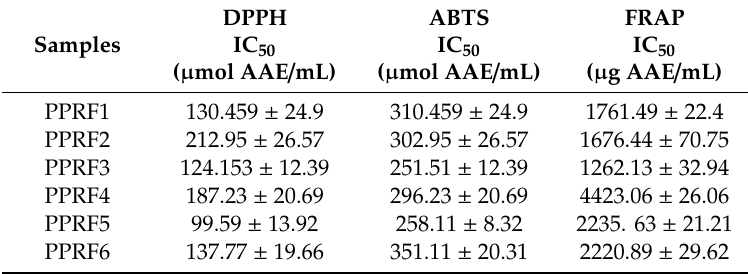
Table 2. Antioxidant properties of polyphenolic-rich fractions of L. tetragona.